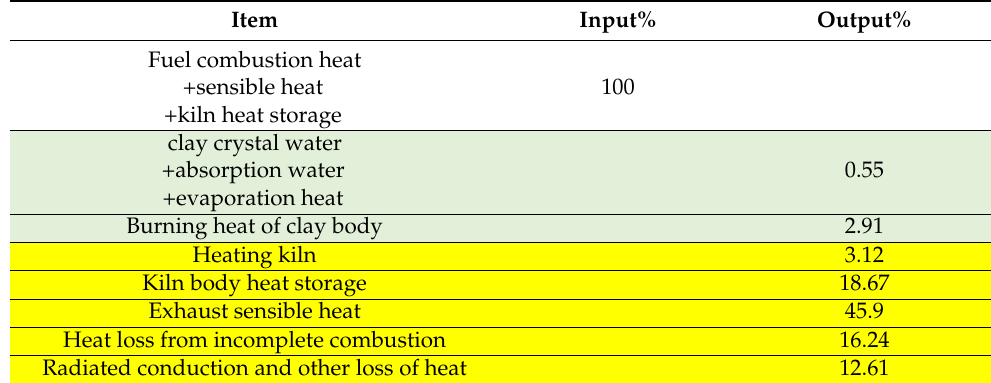
Table 2. Kiln firing thermal efficiency (Tzu-Chieh Lee, 2018) [23,33].